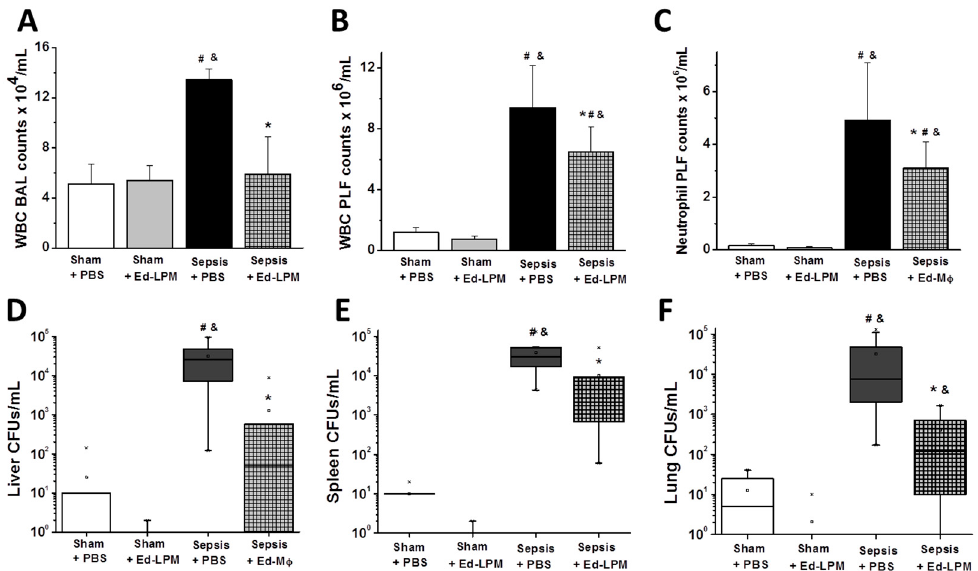
Figure 2. Embryonic derived macrophages (Ed-LPM) decrease severity of fecal sepsis. Ed-LPM therapy attenuated the sepsis induced increase in white blood cell (WBC) infiltration in the broncho-alveolar lavage (BAL) fluid (Panel A , p = 0.007) and peritoneal lavage (PLF) fluid (Panel B , p < 0.0001); this effect appeared largely due to reduced neutrophil infiltration (Panel C , p < 0.0001). Ed-LPM therapy reduced the sepsis induced increase in bacterial load in the liver (Panel D , p = 0.006), spleen (Panel E , p = 0.012), and the lung (Panel F , p = 0.032) n = 6 for Sham groups and 10–11 for groups with cecal slurry induced Sepsis; * p < 0.05 vs. sepsis + PBS group, # p < 0.05 vs. Sham + PBS group, & p < 0.05 vs. Sham + ED-LPM group.